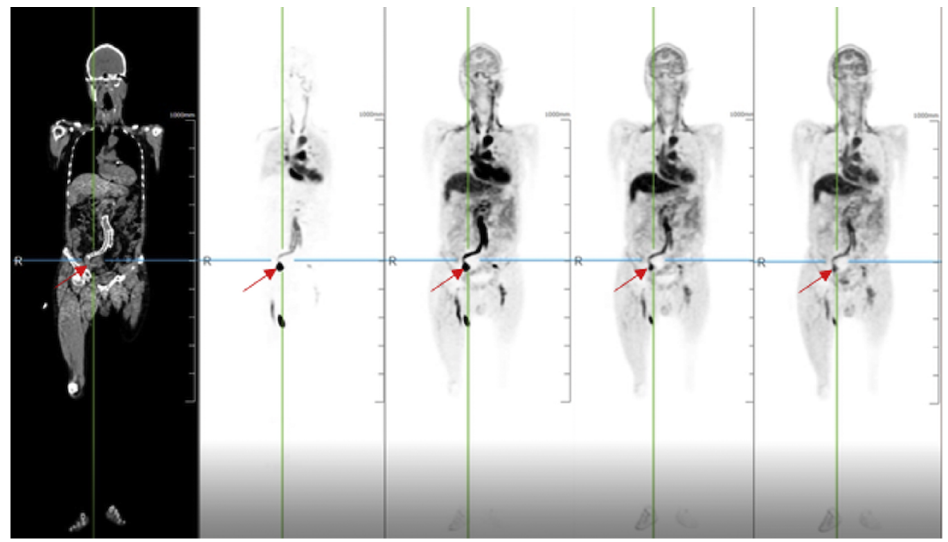
Figure 1. Radiotracer angiography. A 71-year-old man with a clipped aneurysm of an internal iliac artery underwent a total-body PET/CT scan. The dynamic imaging demonstrated that blood flow existed in the aneurysm at the arterial phase. Reprinted with permission from Ref. [7]. Copyright 2020